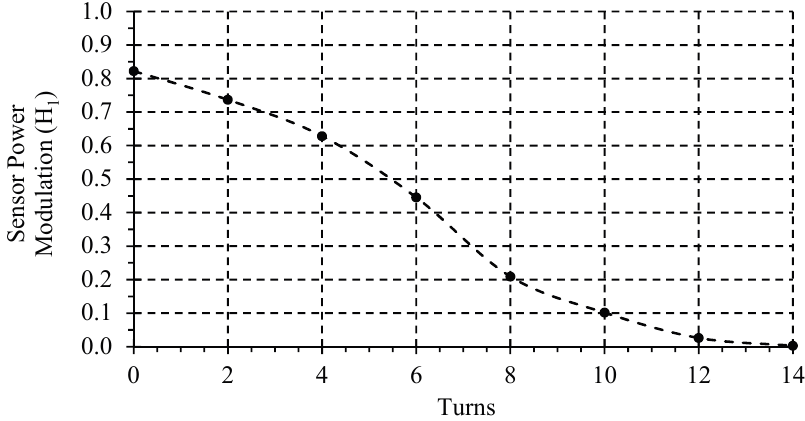
Figure 5. Calibration curve of the sensor loss modulation H 1 emulated by means of a variable optical